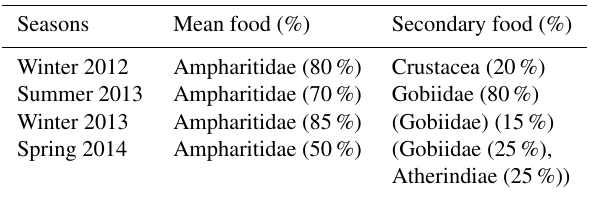
Table 2. Prey frequency percent in Persian